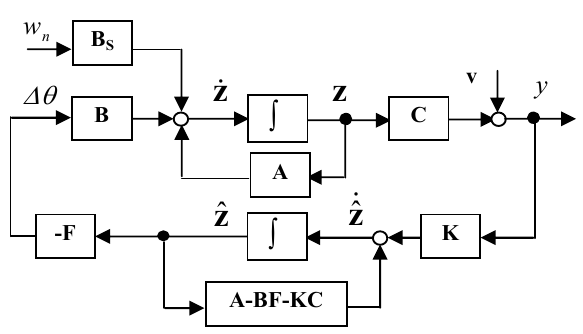
Figure 3 Block diagram of LQG